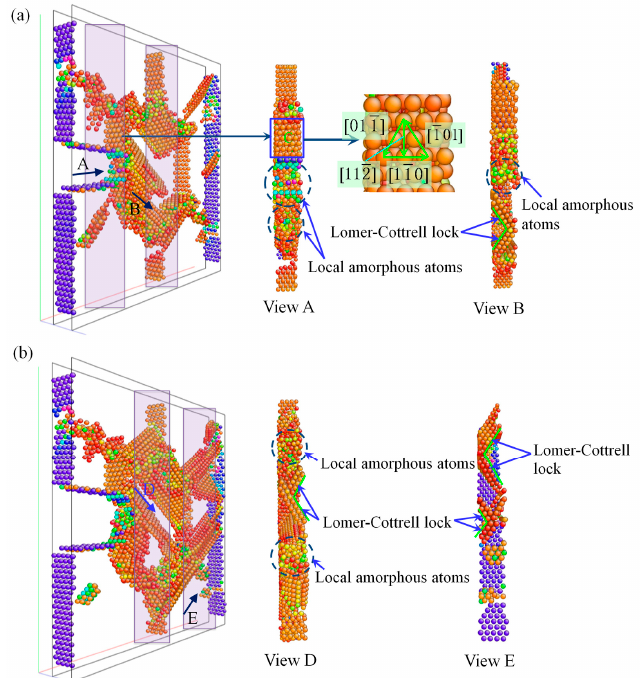
Figure 10. Detailed evolution of atomic configuration in nanoscale polycrystal nickel at the strain rate of 2 × 10 10 s − 1 : ( a ) ε = 0.096; ( b ) ε = 0.18. (All the configurations are characterized by CSP, stacking faults are companied by Shockley partial dislocations).